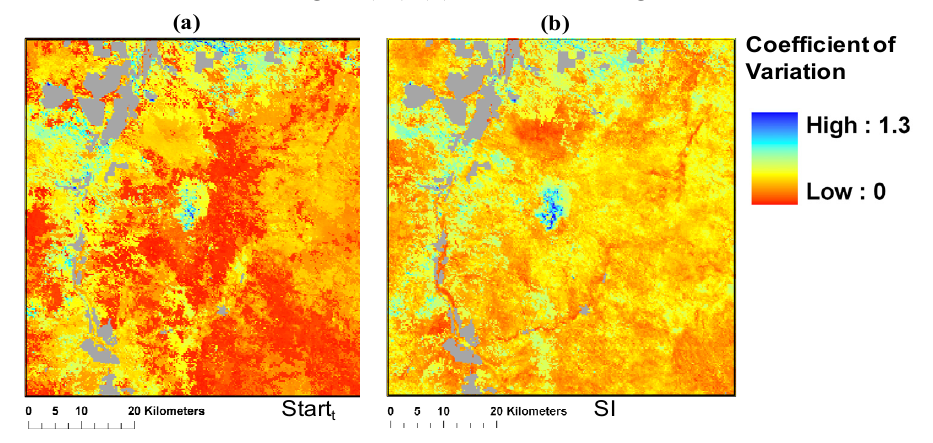
Figure 9. Spatial patterns of the coefficient of variation (COV) for the start of the season (SOS) (a) and the small NDVI integral (SI) (b) for 2001 through